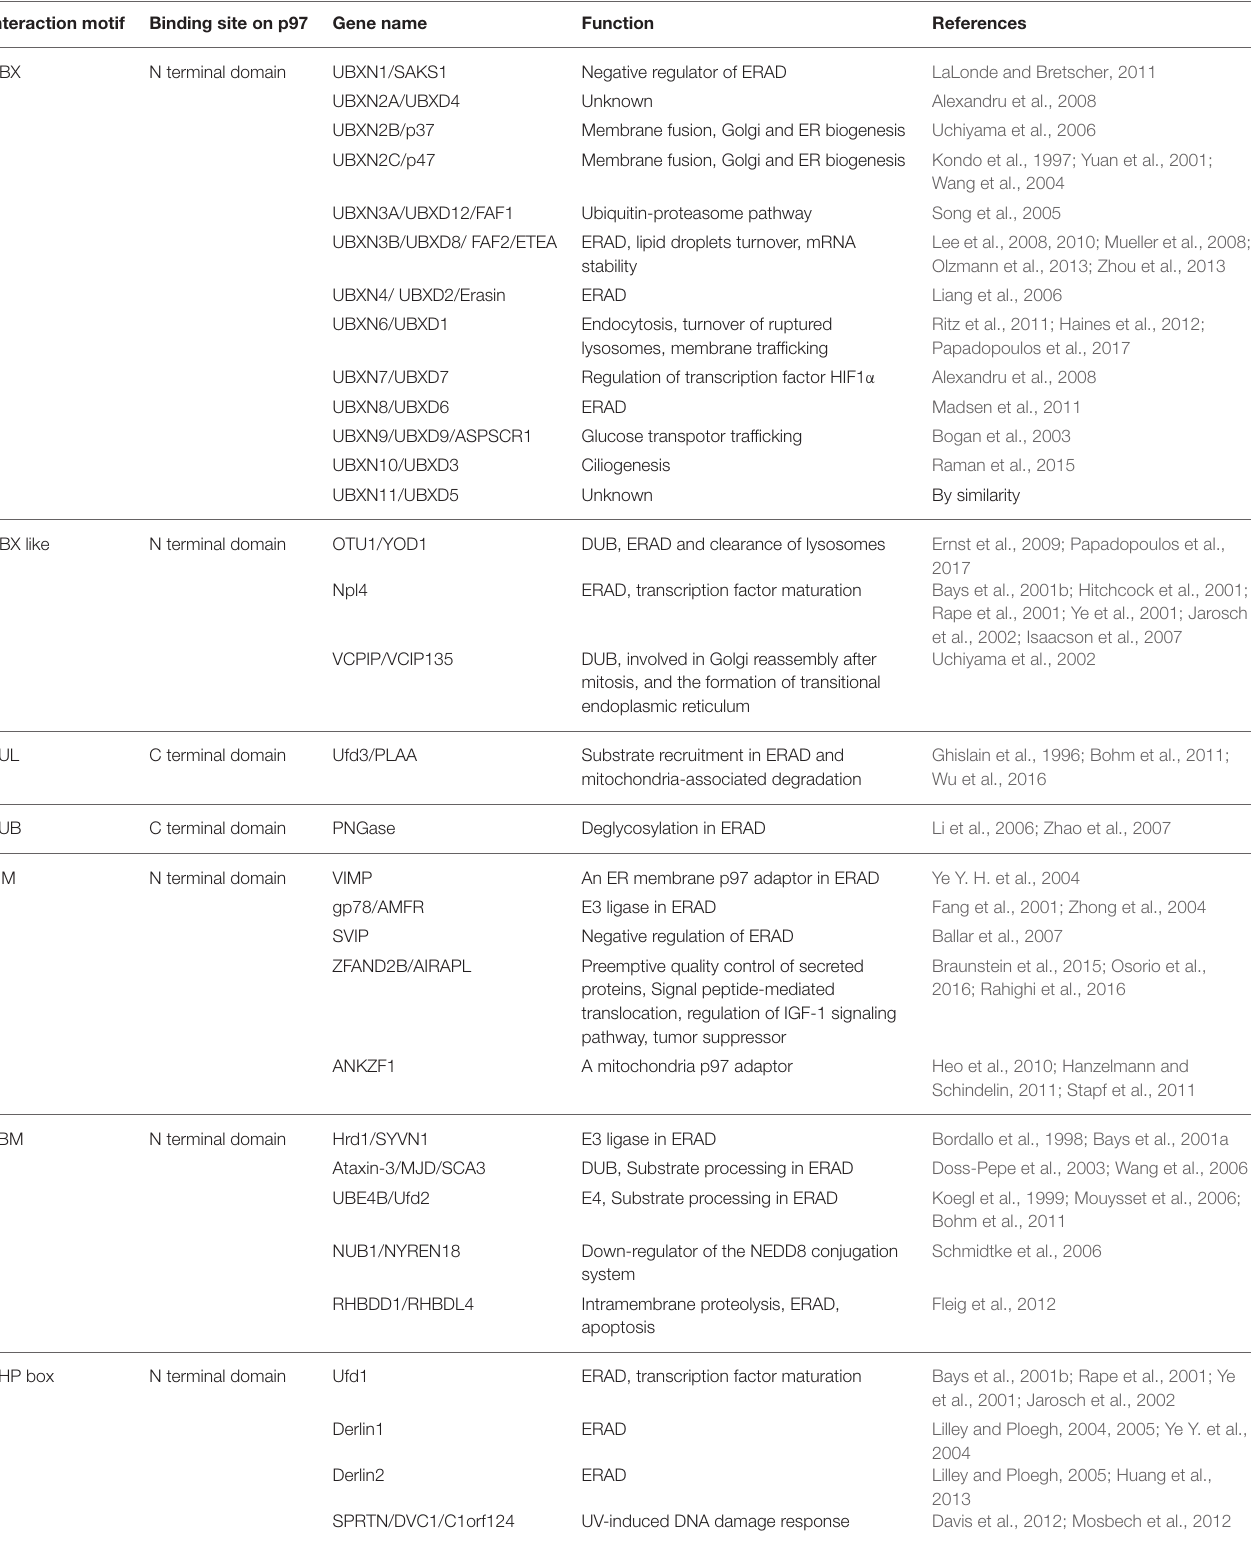
TABLE 1 | p97-interacting proteins. Interaction motif Binding site on p97 Gene